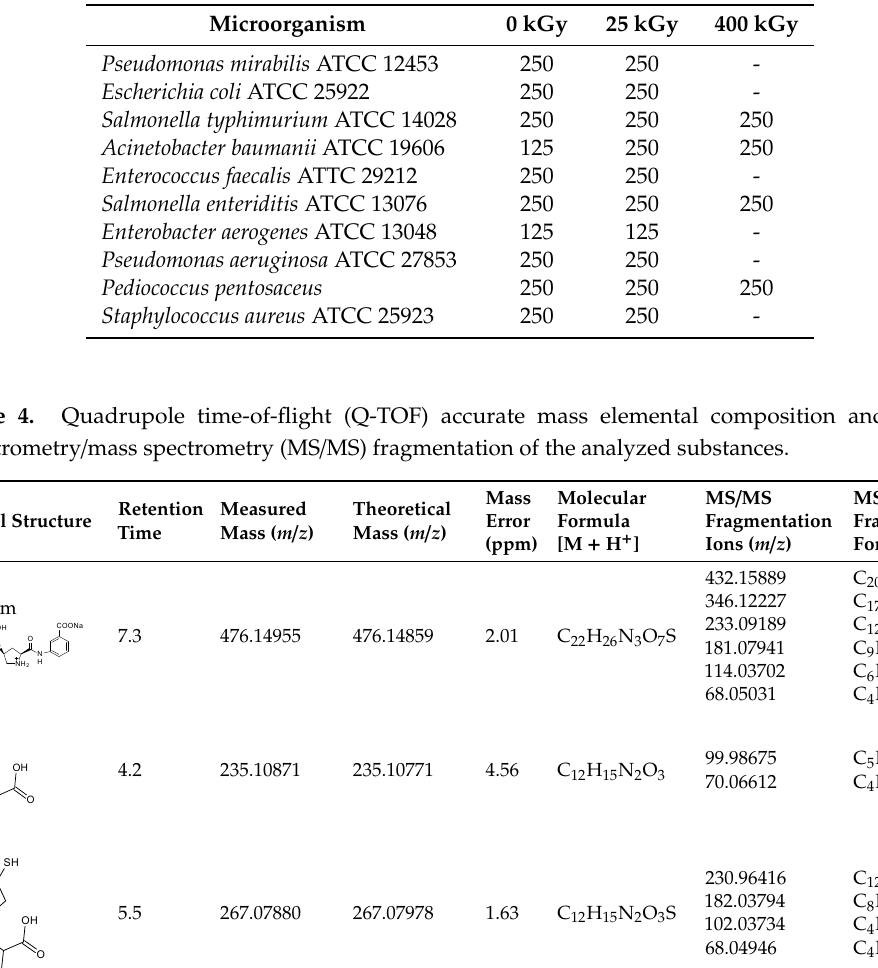
Table 3. MIC values (mg·L − 1 ) of non-irradiated and irradiated ertapenem samples.